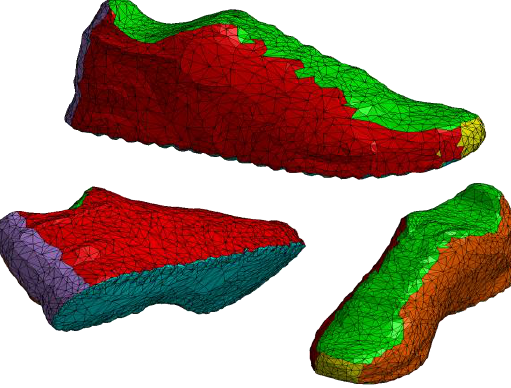
Figure 6. The grouping result of a shoe example using six candidate images.